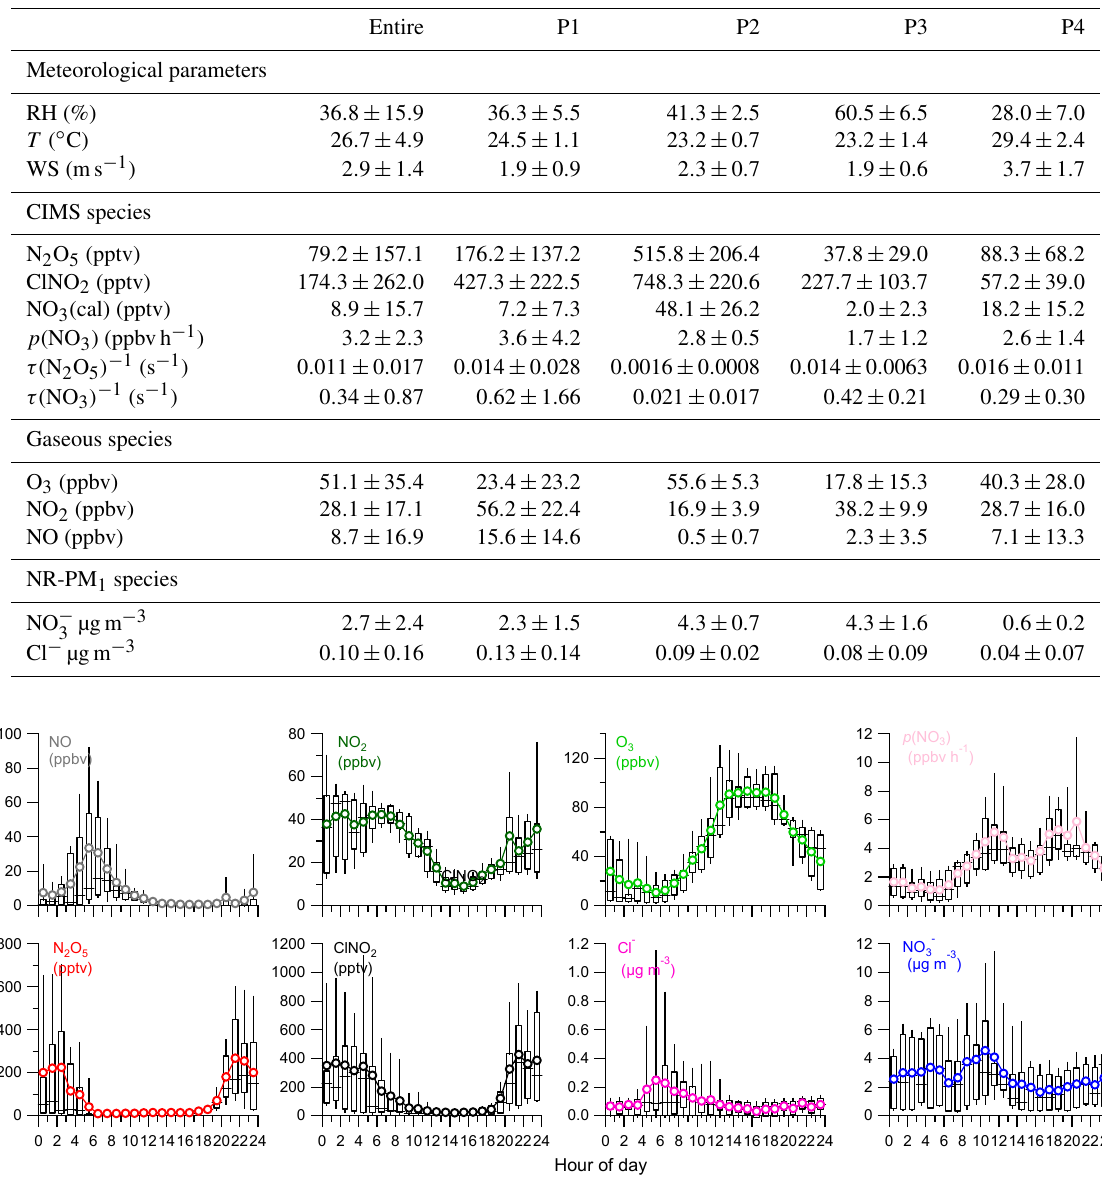
Figure 2. Diurnal variations of trace gases (NO, NO 2 , O 3 ), IAP-CIMS species (N 2 O 5 , ClNO 2 ) , nitrate radical production rate p (NO 3 ), and ) NR-PM 1 species (Cl − , NO − 3